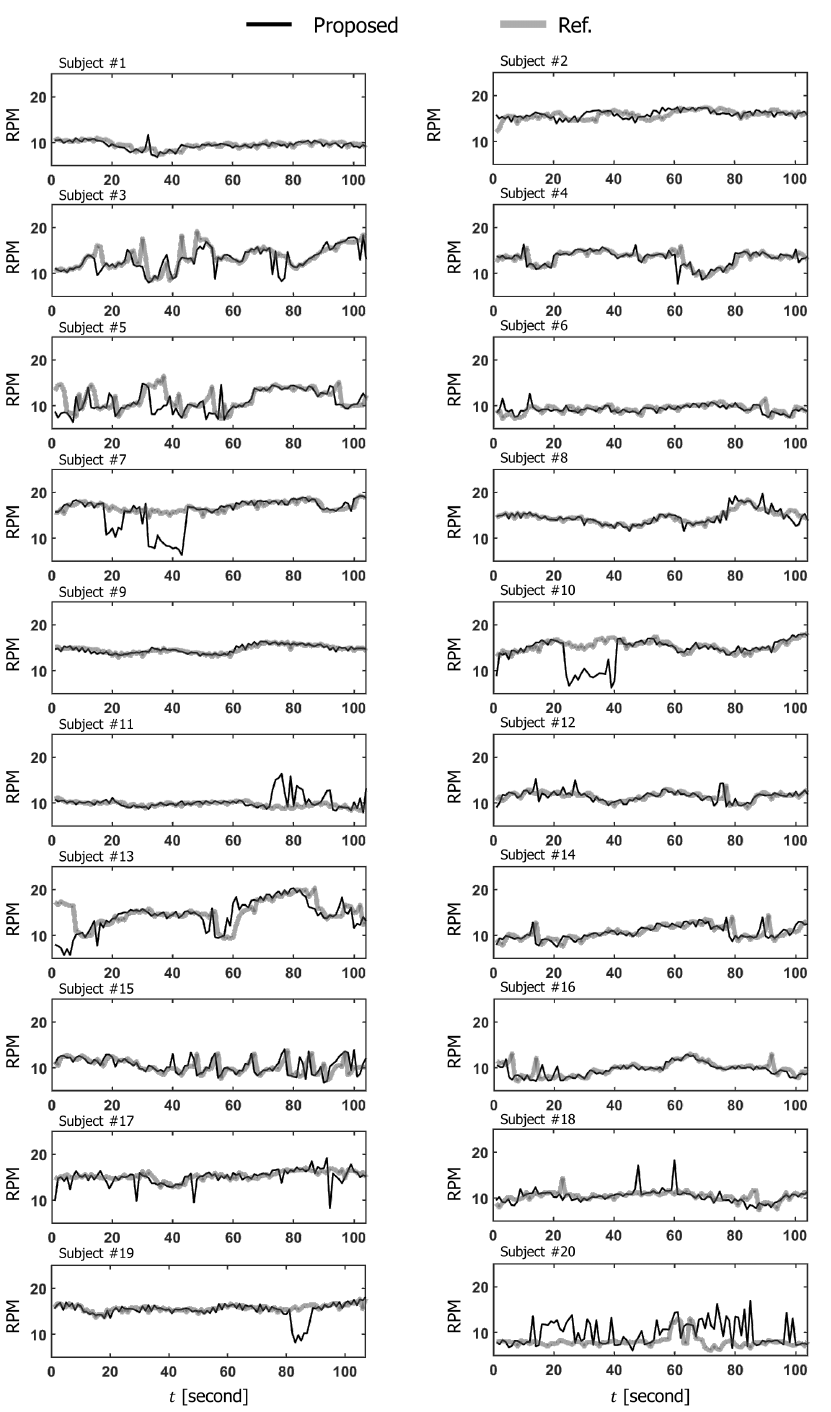
Figure 6. Comparison of the extracted respiration rate using the proposed method with the referenced ground truth for 20